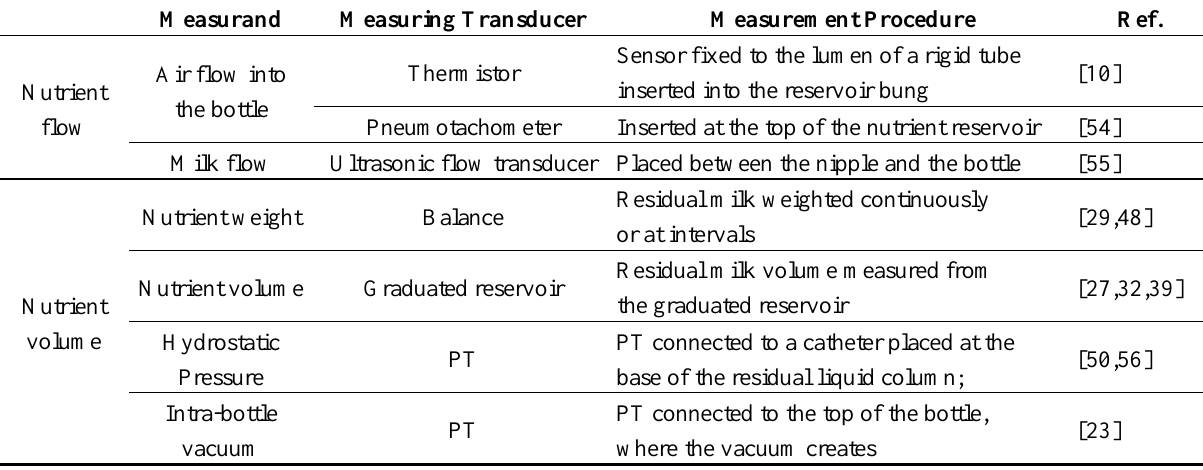
Table 5. Overview of the measuring systems used to monitor the nutrient consumption: measurands, sensors and measurement procedures. Measurement Procedure